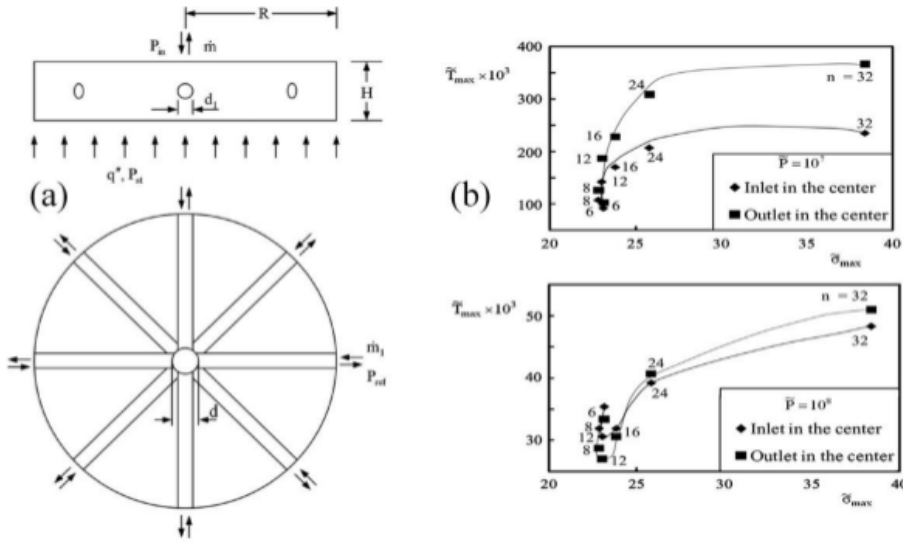
Figure 5: (a) Radial cooling channel configuration embedded in the circular plate. (b) The effect of the number of cooling ducts on the maxi- mum temperature and stress.